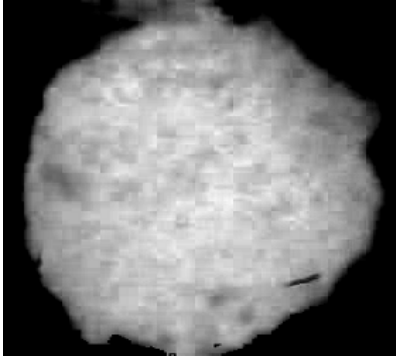
Figure 7. Red–Green–Blue (RGB) image ( a ), red channel ( b ), green channel ( c ), and blue channel ( d ), Hue–Saturation–Value